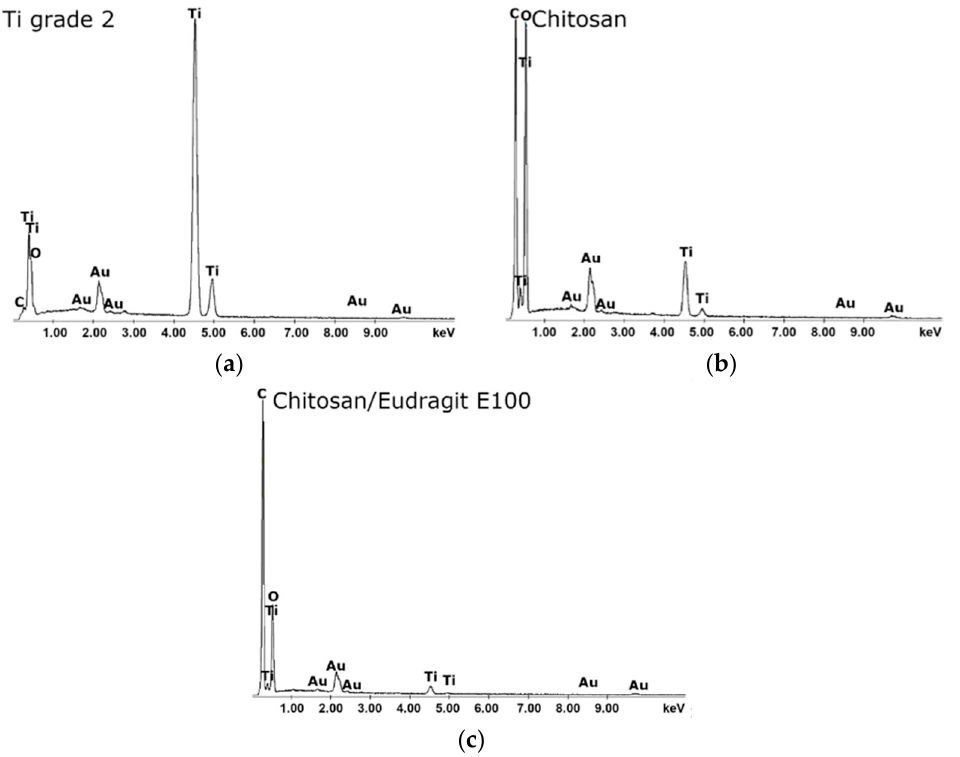
Figure 2. X-ray energy dispersion spectroscopy spectra of the Ti grade 2 substrate ( a ), the sample with the chitosan coating ( b ), and ( c ) sample with chitosan/Eudragit E 100 coating (A1 sample).